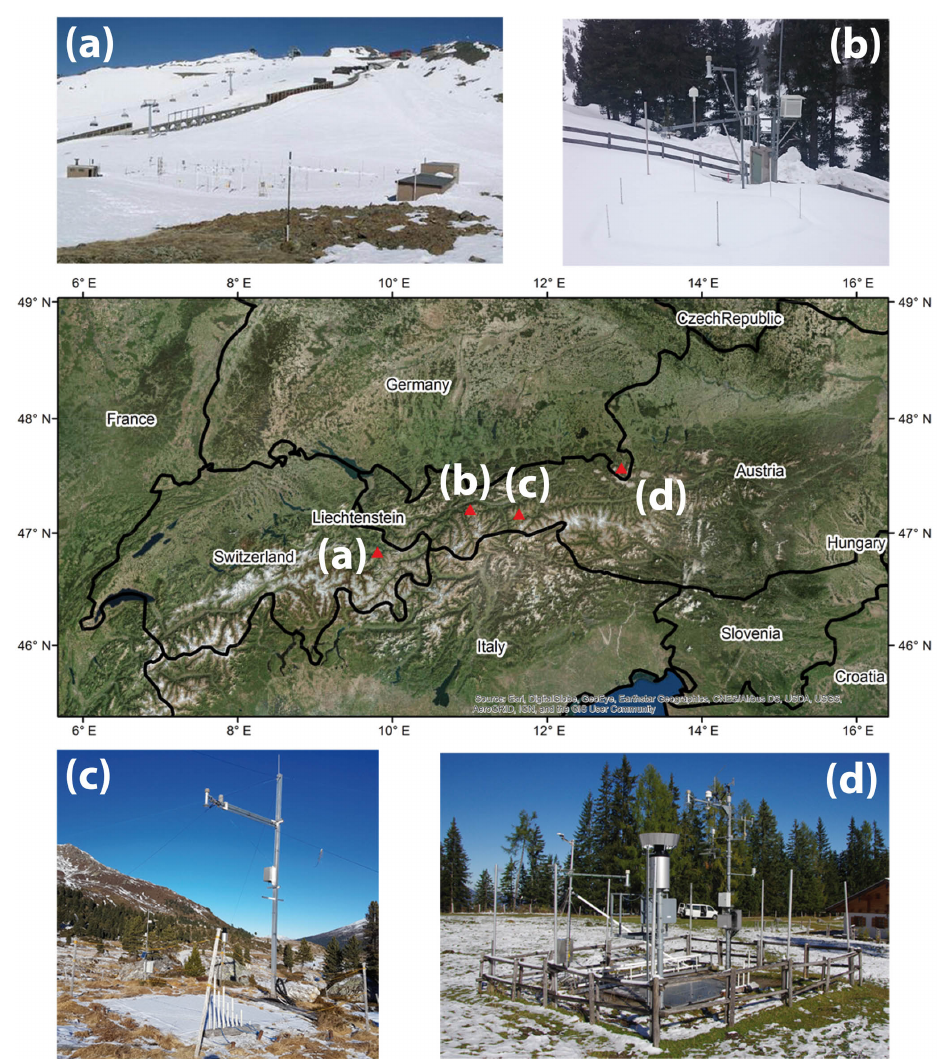
Figure 1. Map of the station locations. Pictures are given for (a) Weissfluhjoch station, (b) Kühtai station, (c) Wattener Lizum station and (d) Kühroint